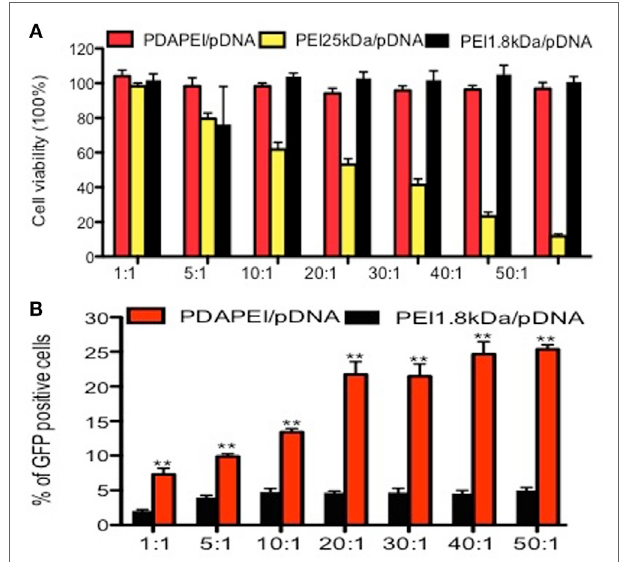
FigUre 3 | cytotoxicity and transfection efficiency in vitro . (a) Cytotoxicity of PDAPEI to RAW246.7 cells tested by CCK-8 assay (viability cells %) at different w/w. (B) Transfection efficiency of PDAPEI to RAW246.7 cells measured with flow cytometry (EGFP positive cells %) at different w/w (red: PDAPEI/pDNA, yellow: PEI 25 kDa/pDNA, black: PEI 1.8 kDa/pDNA). The experiments have been repeated for three times. (* p < 0.05, ** p <